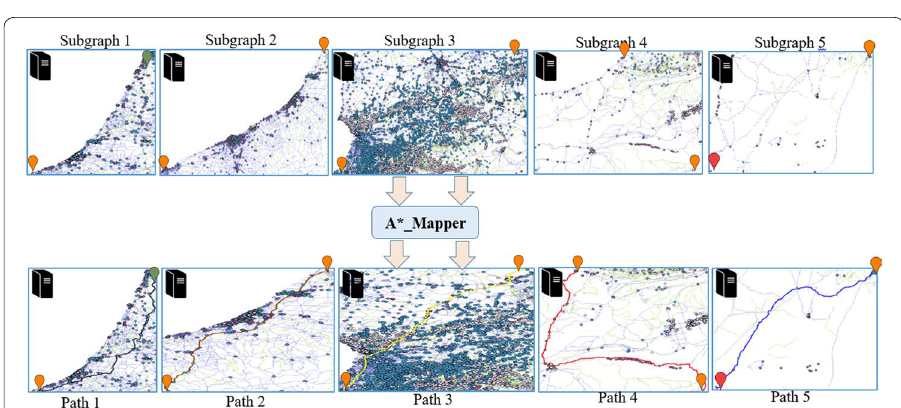
Fig. 8 Map stage: computation of partial solutions. The intermediate paths are computed across the five slave